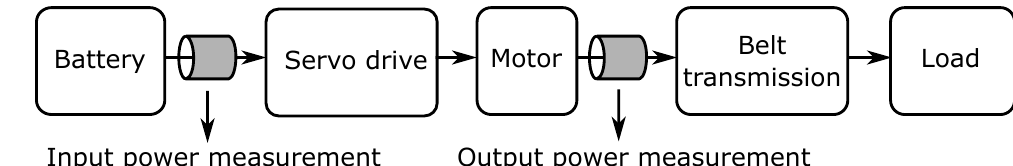
Figure 7. Location of power measurements in the motor testbed. Electrical power